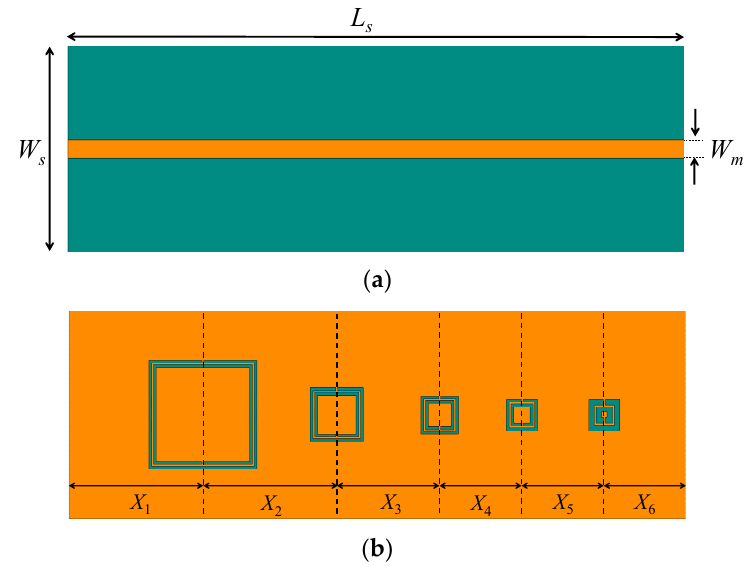
Figure 1. Microwave sensor array ( a ) front surface and ( b ) back surface with Sensor 1 to Sensor 5, shown from left to right, corresponding to resonance frequencies of 1.36 GHz, 3.09 GHz, 5 GHz, 6.82 GHz, and 8.91 GHz, respectively.